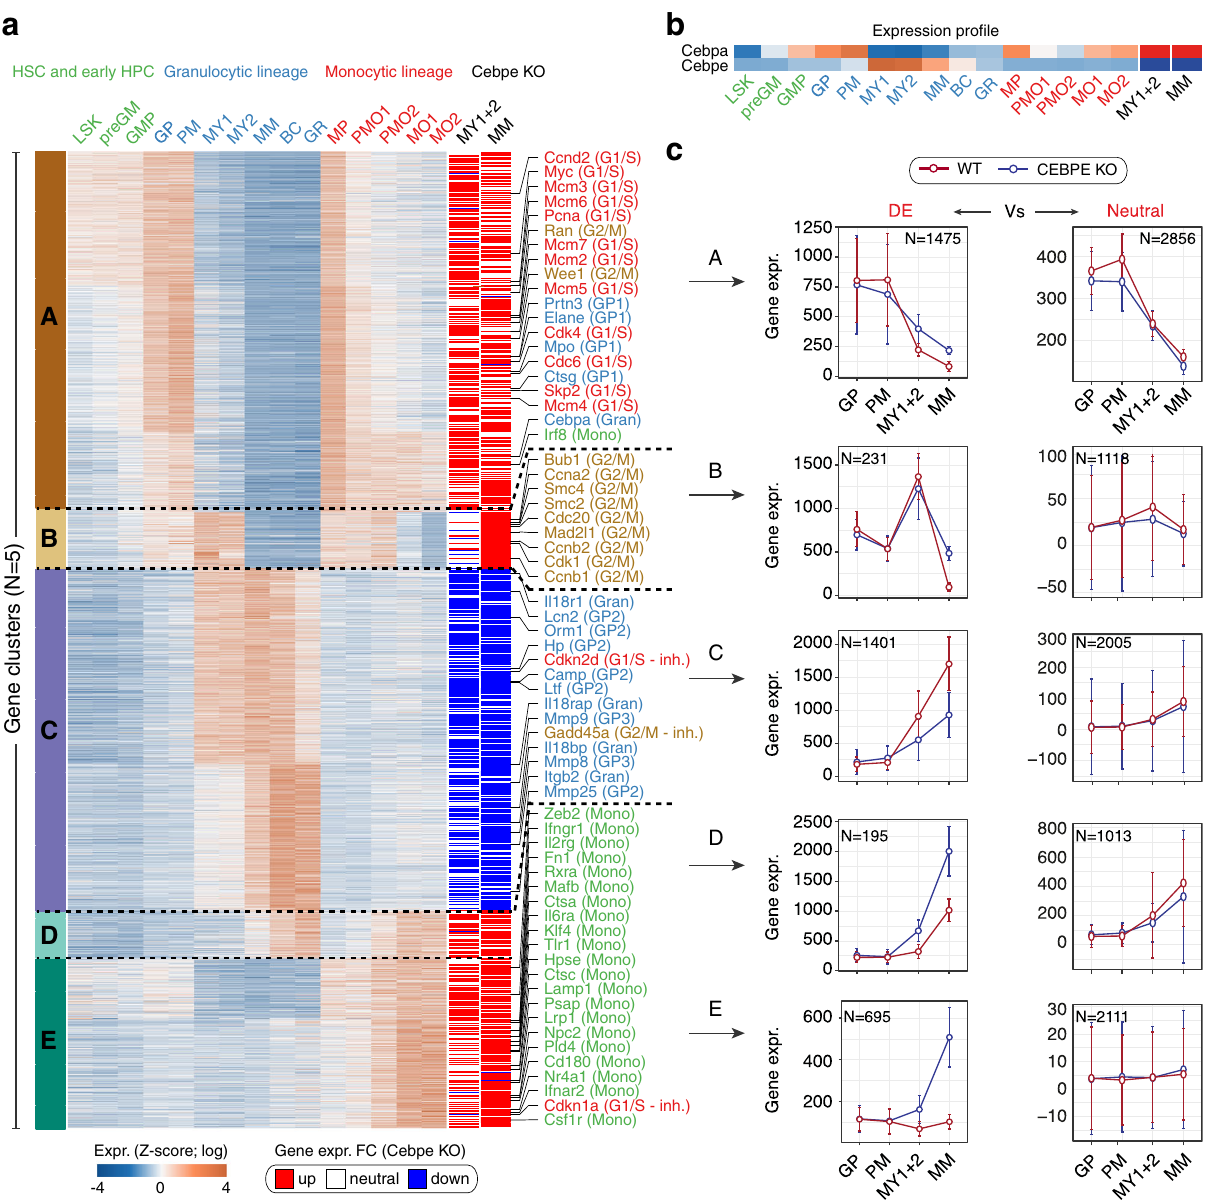
Fig. 2 Five gene clusters strati fi ed based on distinct gene expression pro fi les during early and late granulocytic and monocytic differentiation. a Unsupervised hierarchical clustering of RNA-seq gene expression pro fi les from sorted BM populations identi fi ed fi fteen minor clusters (Supplementary Fig. 2) which based on similarity, were merged into the following fi ve major gene expression clusters: Cluster A(GMP) — genes expressed during early granulocytic and monocytic differentiation (i.e., in LSKs, preGMs, GMPs, GPs, PMs, and MPs); cluster B(MY) and cluster C(GR) — genes transiently expressed in MY1 and MY2 and terminally upregulated in MM, BC, GR during late granulocytic differentiation, respectively; cluster D(GR + MO) — genes terminally upregulated during both late granulocytic and monocytic differentiation, and fi nally cluster E(MO) — genes upregulated exclusively during monocytic differentiation (i.e., in PMO1s, PMO2s, MO1s, and MO2s). Only differentially expressed (DE) genes are shown in the heatmap (all genes are shown in Supplementary Fig. 2). Gene symbols for selected genes representing (i) master regulators of G1/S and G2/M phase progression, (ii) sequentially expressed primary, secondary, and tertiary granule proteins (GP1, GP2, and GP3), and (iii) granulocytic (Gran) and monocytic (Mono) differentiation genes are depicted for each gene cluster. b RNA-seq gene expression pro fi les of Cepba and Cebpe in sorted Cebpe WT and Cebpe KO BM populations. c The line plots show the median expression pro fi le of genes (median; whiskers represent the standard error) from each cluster whose expression is signi fi cantly differentially expressed (DE, left) or remains neutral (right) in BM populations of Cebpe KO as compared to Cebpe WT mice. Source data are provided as a Source Data fi bona fi de E2F1-bound regions (Fig. 3d, E2F1 ChIP-seq data from Fig. 3c). This suggests that CEBPE interacts with E2F and confers ESCs) and was independent of the presence of CEBP binding repression of E2F-mediated target gene transcription at the motifs (Fig. 3e). In line with this, analysis of Cebpe KO mice promoter level. Subsequent functional validation utilizing EMSA demonstrated selective upregulation of genes that were enriched and reporter assays in a granulocytic differentiation model (i.e., for E2F binding motifs at their promoters (cluster B (MY),